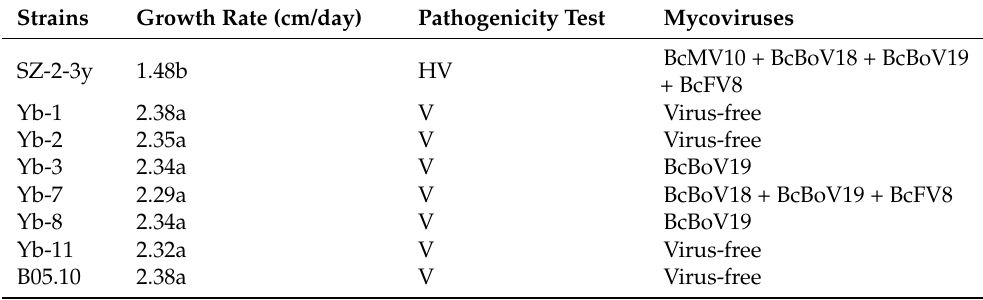
Table 2. Horizontal transmission of mycoviruses from SZ-2-3y to